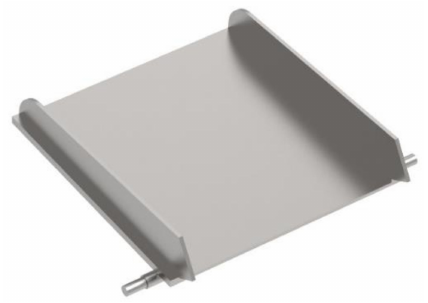
Figure 19. Loading tray subassembly.